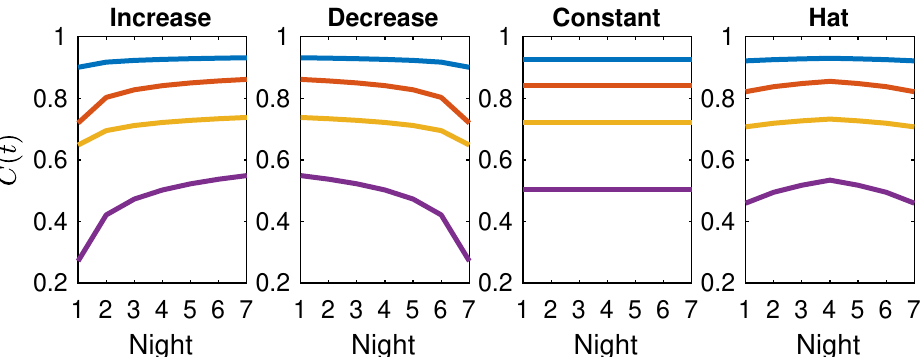
Figure 5. Effectiveness of each of the four female calling strategies described in Section 2.1 and Figure 1. Capture and mating probability C ( t ) for four representative moths with { R , D } = { 0.75,10 − 1.5 m 2 /s} (blue curve), { 0.75,10 − 3.5 m 2 /s} (red curve), { 0.25,10 − 1.5 m 2 /s} (yellow curve), and { 0.25,10 − 3.5 m 2 /s} (purple curve). Calling times t call ( k ) for 1 ≤ k ≤ 7 nights are specified in Section 4.3. Male moths of the highest quality display similar capture and mating probability across female strategies, with C ( t ) (cid:39) 1 in all cases. For intermediate quality moths C ( t ) depends on the chosen female